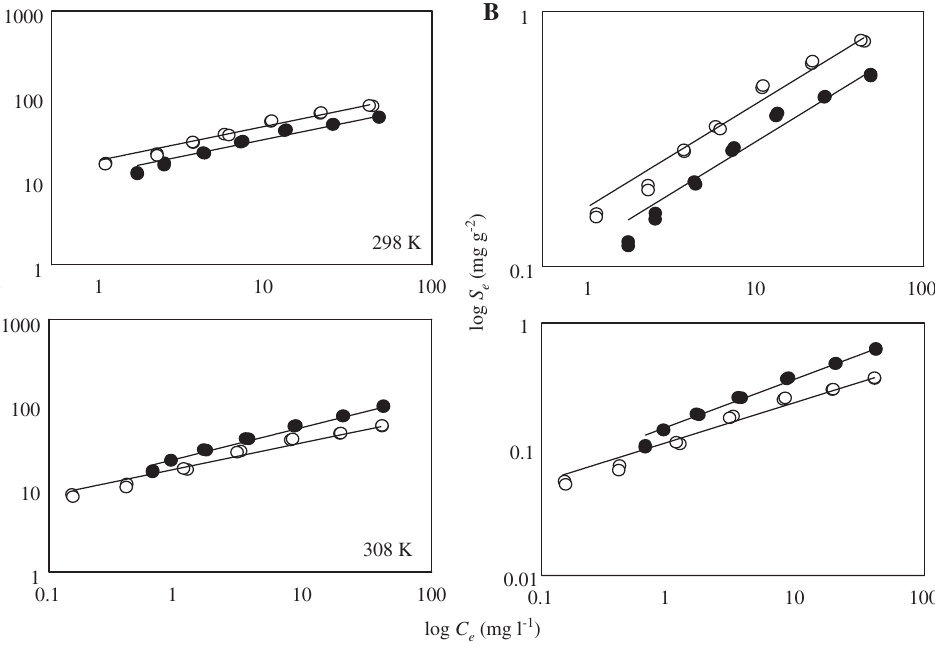
Figure 2: Adsorption isotherms of methylene blue on multi-walled carbon nanotubes (MWCNTs) at two different temperatures. Circles (• and ○) represent MWCNTs and oxidized MWCNTs (MWCNTs-Ox), respectively: (A) solid phase concentration on unit mass basis; (B) solid phase concentration on unit surface area